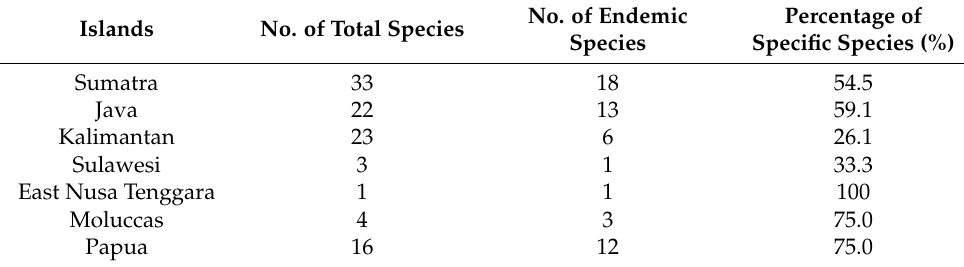
Table 1. Species composition of bagworms species in Indonesia.